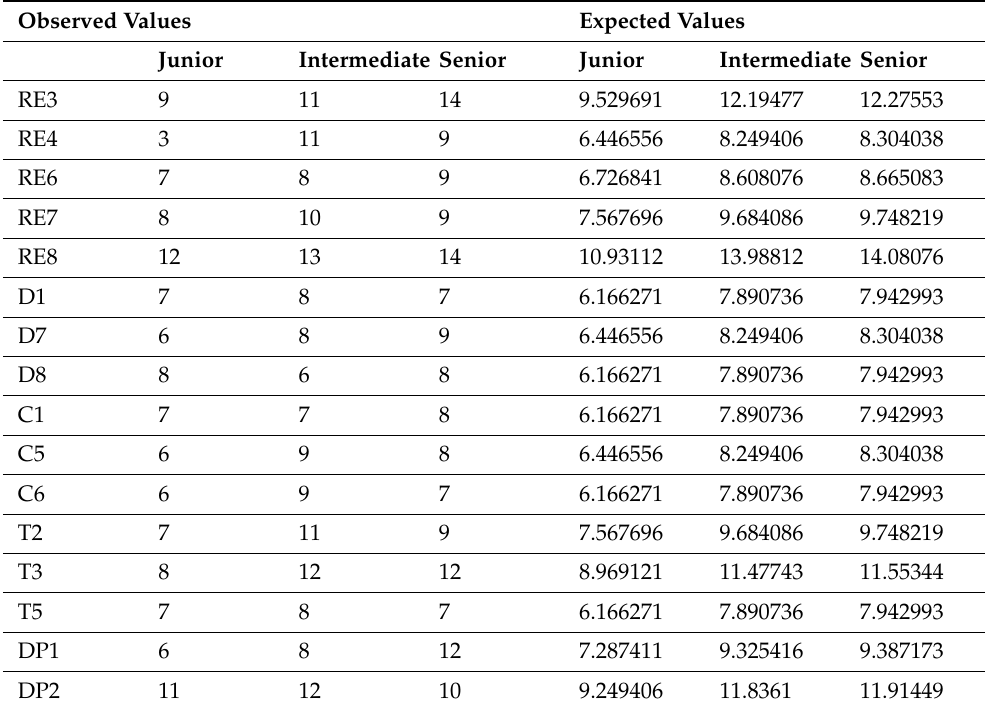
Table 6. Observed and expected values of selected GSD security practices by GSD practitioners with varying